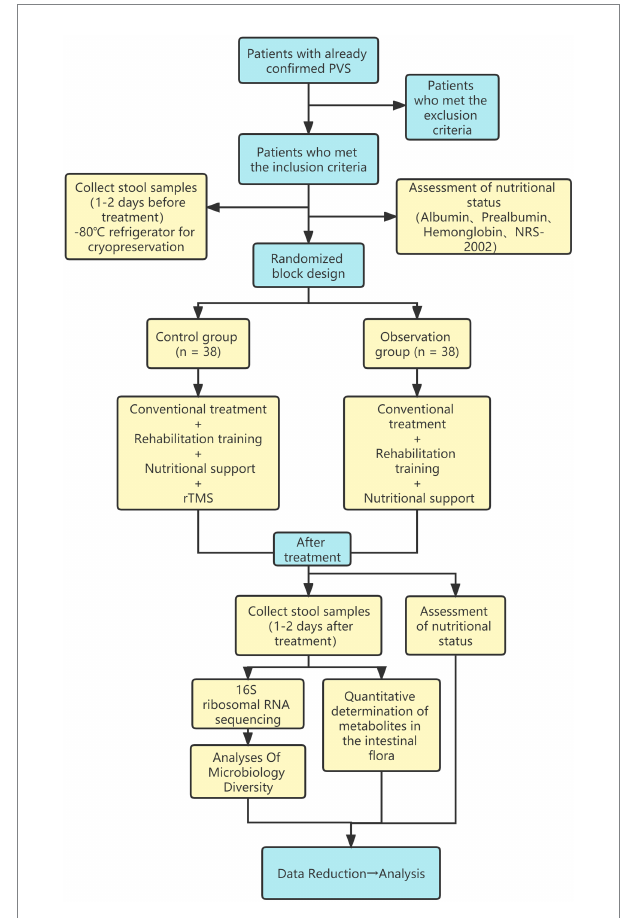
FIGURE 1 The flow chart of this